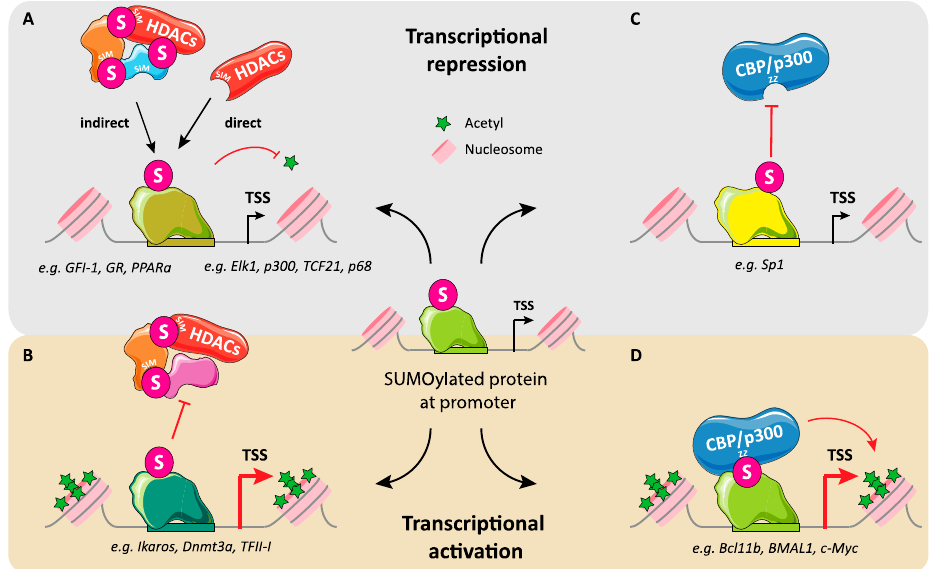
Figure 4. Interplay between SUMO, HDACs and HATs. Histone acetyltransferases and histone deacetylases are key co-transcriptional regulators. Their action can be favored or disfavored by SUMO conjugated to either transcription factors, other cotranscriptional regulators or even themselves. Several generic situations are presented here. They are non-exhaustive. Examples of SUMOylated TF are given for each situation ( A ) HDACs recruitment by SUMOylated TFs. This can be achieved directly or indirectly through SIM-SUMO interactions, leading to chromatin deacetylation and, thereby, transcriptional repression. ( B ) Inhibition of HDACs recruitment by SUMOylated TFs. This permits higher levels of chromatin acetylation and favors transcription. ( C ) Inhibition of HAT recruitment by SUMOylated TFs. p300/CBP are archetypical HATs. Inhibition of their recruitment at promoters by SUMOylated TFs diminishes histone acetylation, which reduces transcriptional activity. ( D ) Recruitment of HATs by SUMOylated TFs. In certain cases, SUMOylated TFs can facilitate HAT recruitment at gene regulatory elements. As HAT and HDACs associate with regulatory factors and other transcriptional cofactors into multi-subunit complexes, it is likely that the regulation of their activity involves group SUMOylation (see Text for details). The same remark holds true for other chromatin-modifying complexes such as KMTs and possibly others whose regulation by SUMO has not been studied yet.